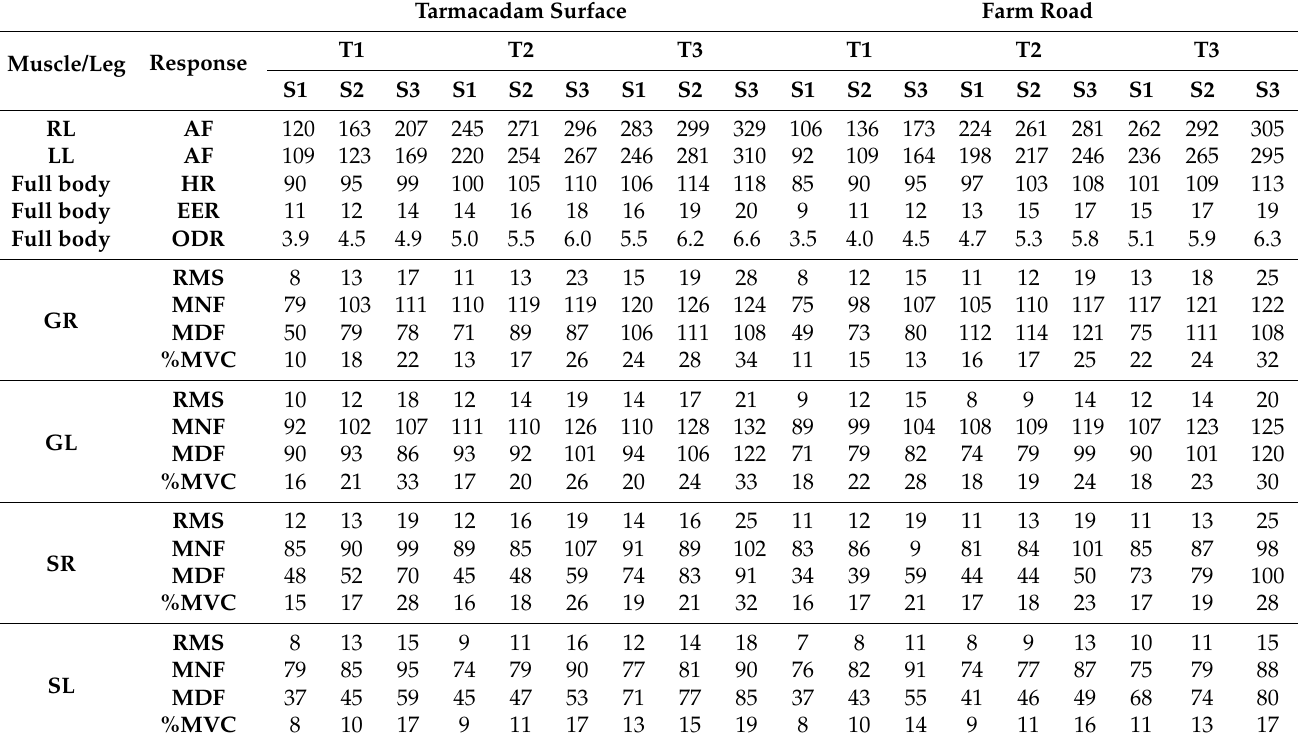
Table 3. Mean of physiological and electromyography responses measured for the selected subjects pertinent to clutch and brake operations with three tractors at three operating speeds and on two operating